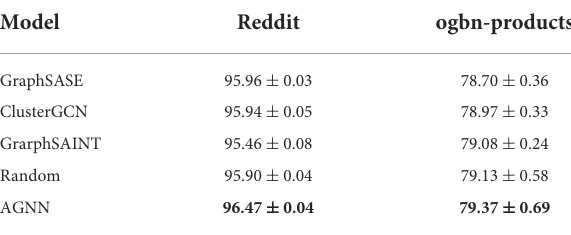
TABLE 4 Node classification accuracies (in percent) on large-scale